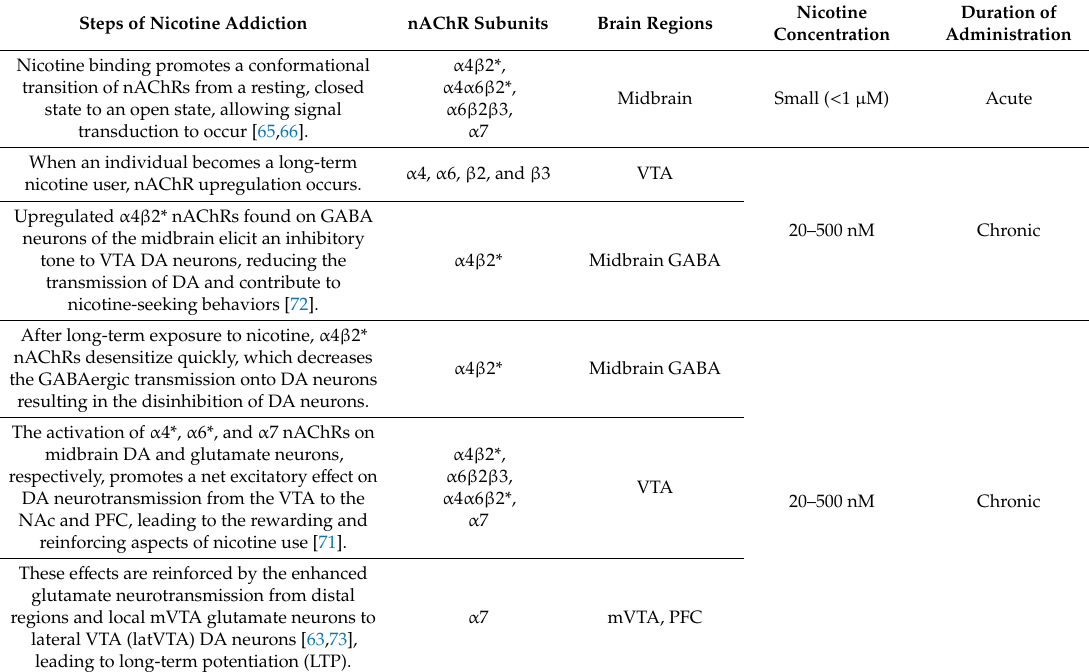
Table 1. Nicotine’s actions in the